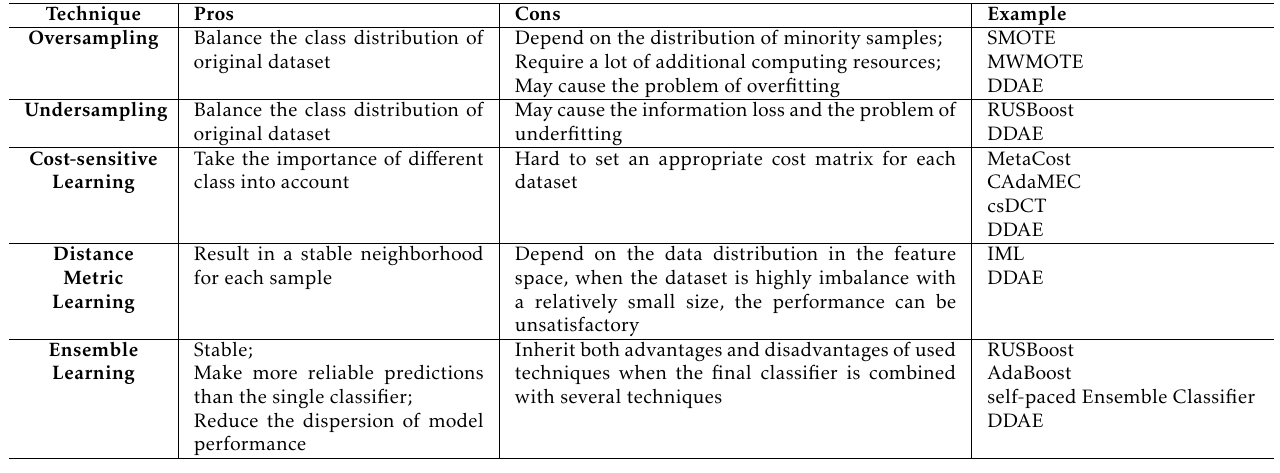
Table 25. Pros and cons of different techniques utilized for dealing with class imbalance